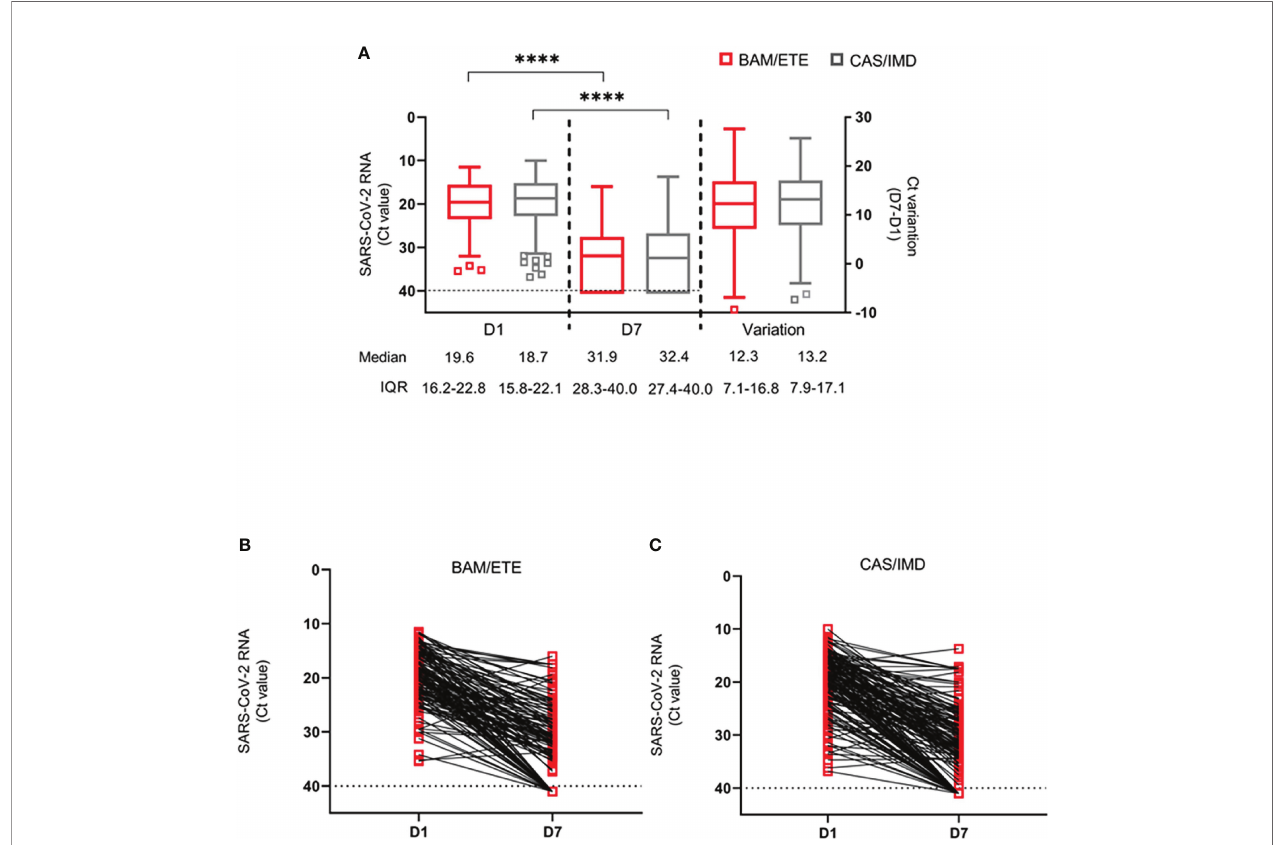
FIGURE 5 | SARS-CoV-2 RNA levels at D1 and D7 in patients treated with CAS/IMD and BAM/ETE. (A) Box-and-whiskers plot showing the comparison of viral loads detected at D1 and D7 in patients treated with BAM/ETE (n=170 and 154, respectively) or CAS/IMD (n=183 and 174, respectively), and the variation of RNA levels observed between the two time-points by intervention (BAM/ETE, n=145; CAS/IMD, n=165). Viral RNA levels are expressed as CT of Orf1ab gene ampli fi cation. Median CT values and IQR are shown. Statistical analysis of the comparisons between treatment groups was performed by Mann – Whitney test: D1, p=0.29; D7, p=0.87; and Variation, p=0.71. CT values at D1 and D7 within each group were compared using paired Wilcoxon sign-rank test, ****p<0.0001. (B, C) Spaghetti-plot showing the Orf1ab CT values measured at D1 and D7 in each patient treated with BAM/ETE (n= 145, B) or CAS/IMD (n=165, C ). Horizontal dashed line represents the limit of detection (CT: 40.0), values ≥ 40 are considered